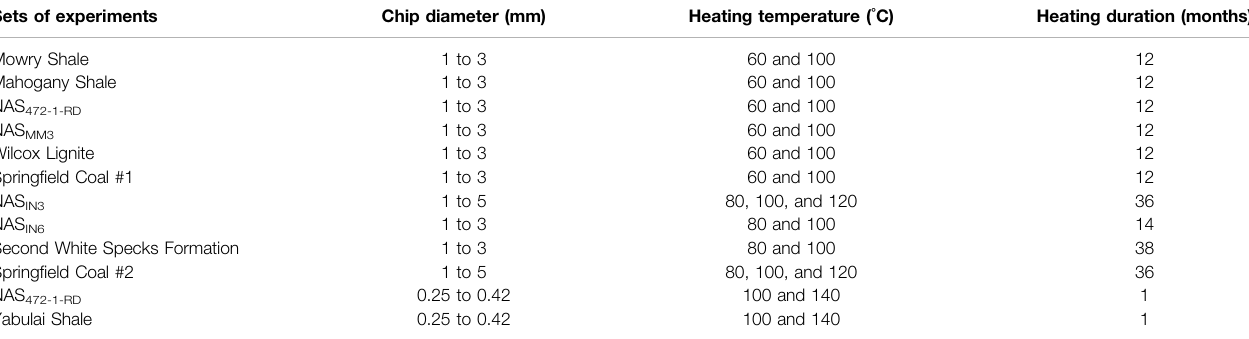
TABLE 2 | Characterization of experimental heating conditions with regard to source rock type, chip diameter, temperature, and heating duration. Sets of